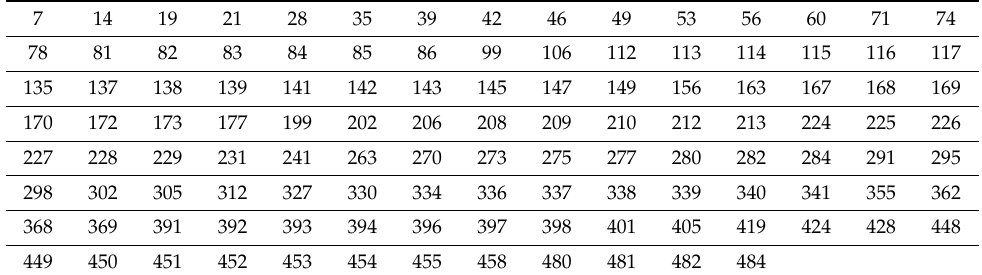
Table 3. x2 corresponding to block P texture template (decimal).